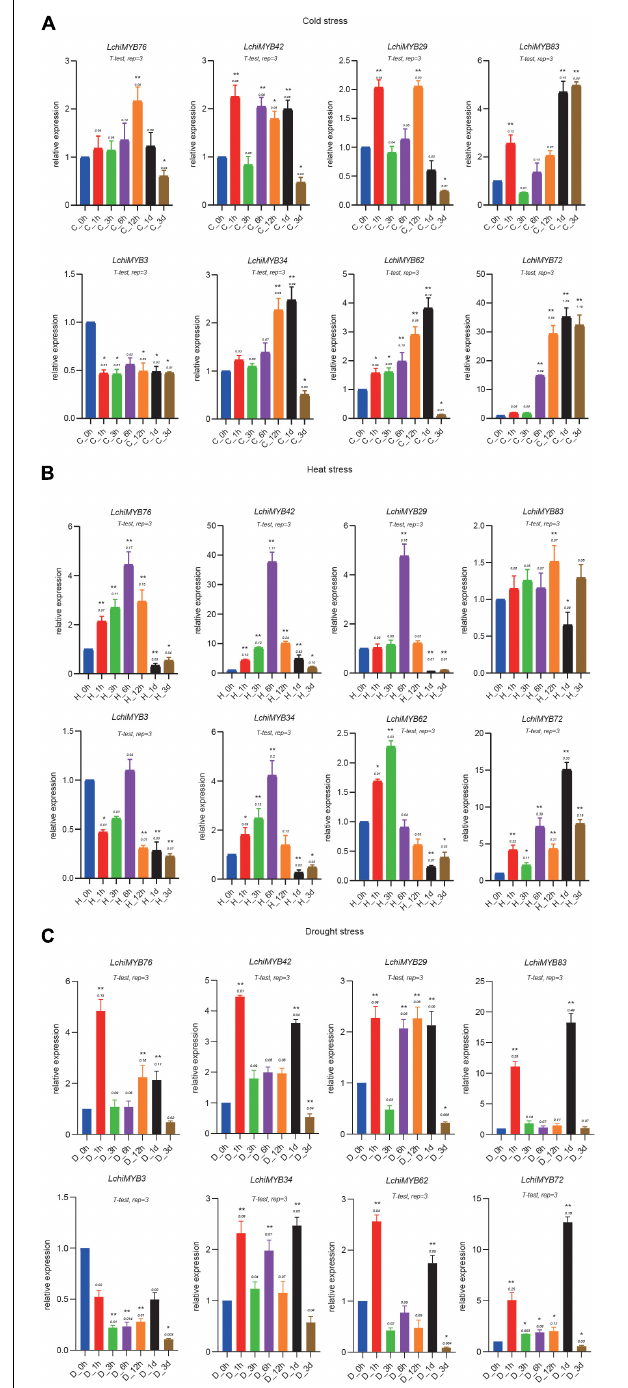
FIGURE 10 | Expression analysis of LchiMYBs under cold (A) , heat (B) , and drought (C) stress treatments, analyzed by qRT-PCR. The Y-axis shows the relative expression level, and the X-axis indicates different time points of stress treatment; the mean ± standard error measurement value (SEM) ( n = 3) is displayed. The t -test represents the Student’s test statistic method, and rep = 3 represents the three biological replicates. The group for each treatment time point compared with the control group; the significantly different ( T -test) * p < 0.05 and ** p <